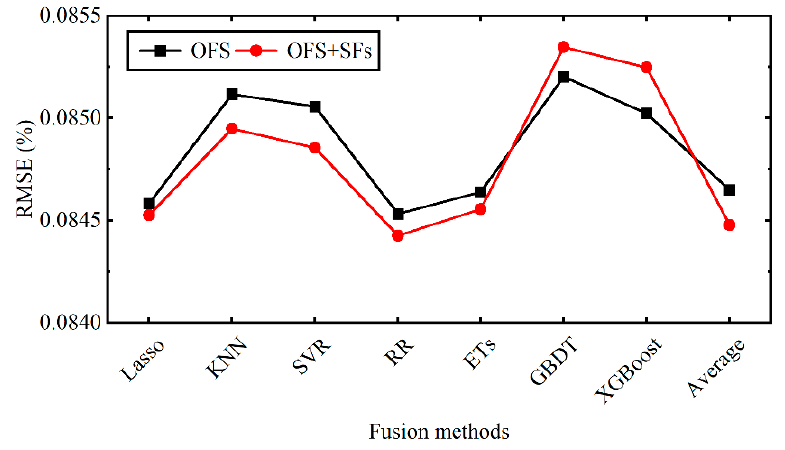
Figure 6. Prediction RMSEs of the proposed method with and without the synthetic features (SFs).